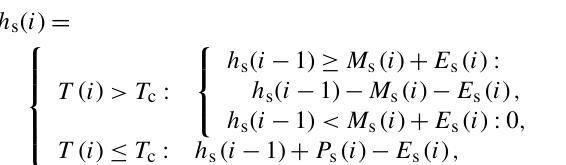
tion (Allen et al., 1998). 21 Global Climate Models (GCMs) are selected as shown in Table 1. Due to uncertainty of each model projection, mean value of 21 GCMs output data under three emission scenarios (SRA2, SRA1B and SRB1), includ- ing shortwave flux at surface (W m − 2 ) ( (cid:49)R s ), precipitation rate change (mm day − 1 ) and air temperature change( (cid:49)T ) are used as ensembled data in this study. Mean value of respec- tive 20C3M output precipitation rate P (cid:48) (mm day − 1 ) 0